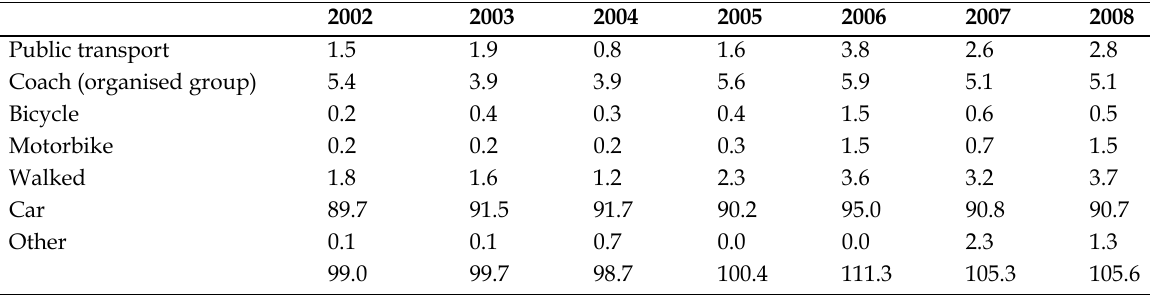
Table 4. Methods of Transport to NT Properties 2002 - 2008 (%)